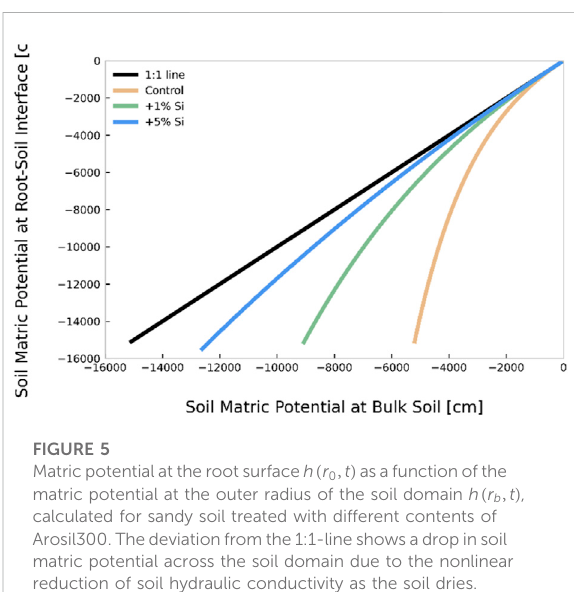
FIGURE 5 Matricpotentialattherootsurface h ( r 0 , t ) asafunctionofthe matric potential at the outer radius of the soil domain h ( r b , t ) , calculated for sandy soil treated with different contents of Arosil300.Thedeviationfromthe1:1-lineshowsadropinsoil matric potential across the soil domain due to the nonlinear reduction of soil hydraulic conductivity as the soil